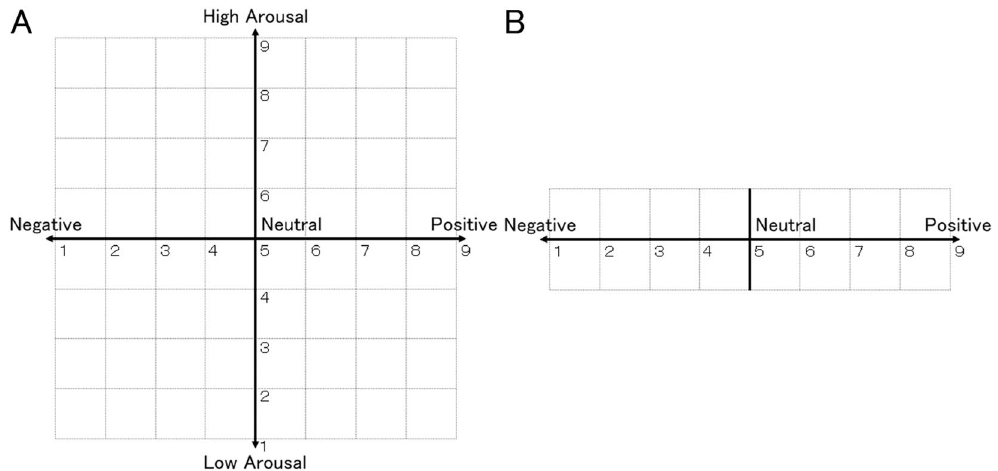
Figure 2. Response panels for valence and arousal ratings in Experiment 1 ( A ) and valence ratings in Experiments 1 and 2 ( B ).